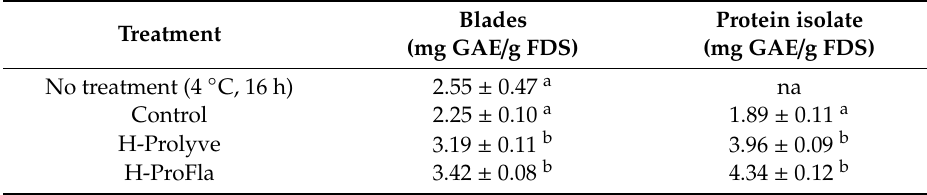
Table 2. Total phenolic content (TPC) of blades and protein isolate from Porphyra dioica following 2 h hydrolysis at 50 ◦ C with Prolyve ® 1000 (H-Prolyve) and 4 h with Prolyve ® 1000 plus Flavourzyme ®